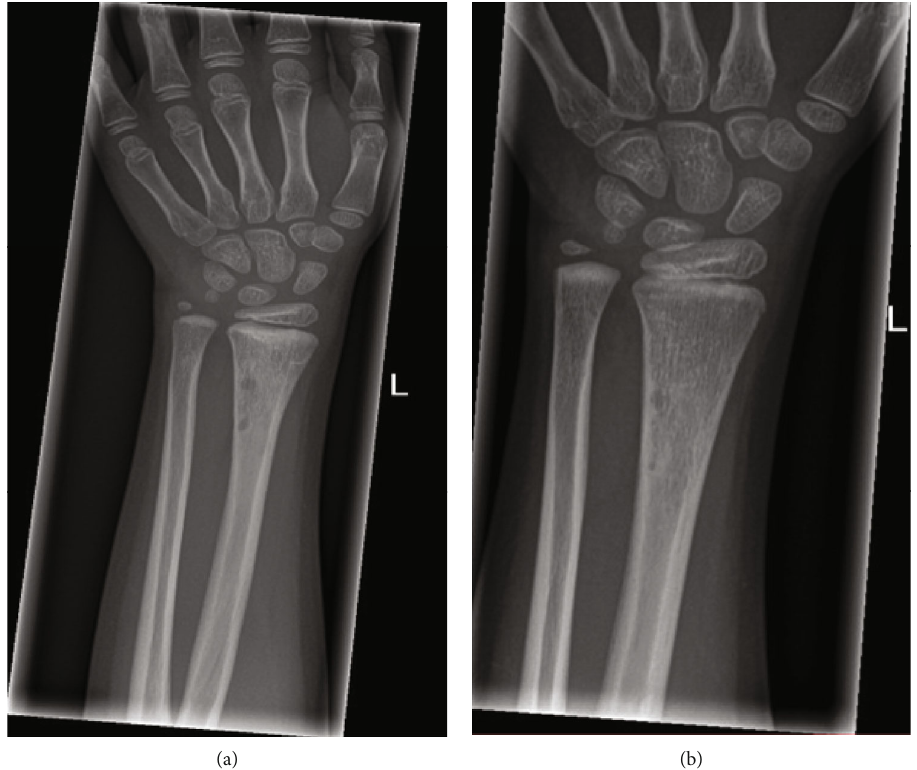
Figure 4: (a) Radiograph showing complete bone healing of the fracture. Two well-circumscribed lucent lesions in the cortex proximal to the previously fractured region. (b) Radiograph showing the lucent lesions fading away.